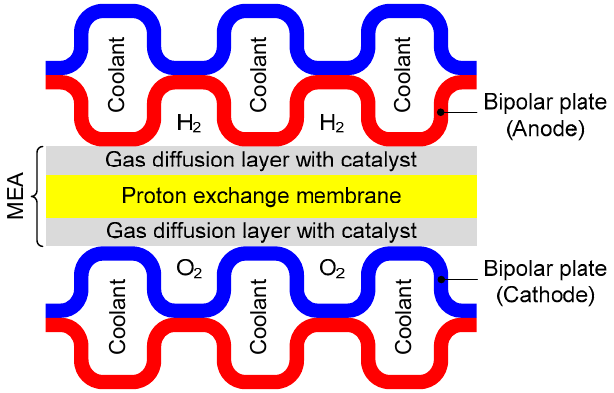
Figure 1. Schematic representation of a proton exchange membrane fuel cell composed by the bipolar plates (BPPs) and the membrane electrode assembly (not to scale).